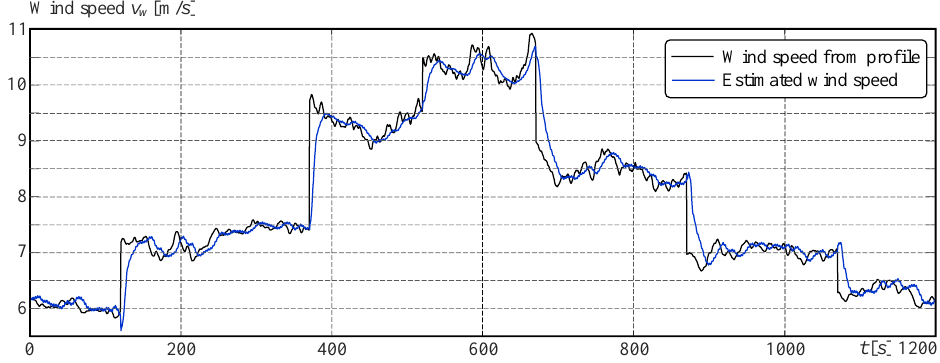
Figure 17. Time series of the wind speed profile and the estimated effective wind speed.